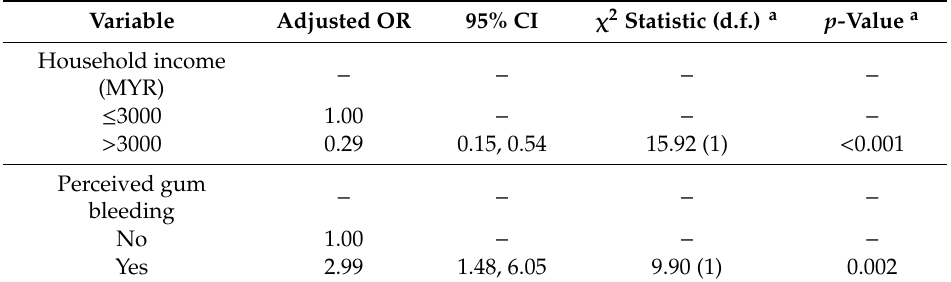
Table 4. Factors associated with moderate to severe gingivitis using multiple logistic regression. Variable Adjusted OR 95% CI χ 2 Statistic (d.f.)